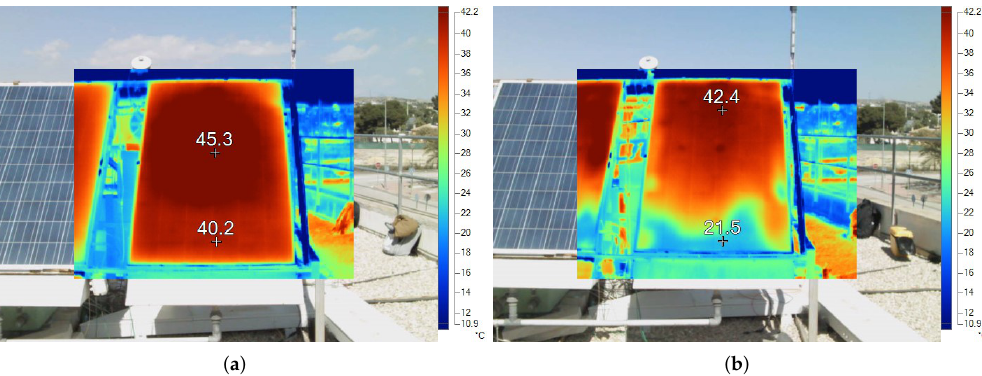
Figure 9. Thermographic evaluation of the module temperature distribution. ( a ) Evaporative chimney on and ( b ) evapora- tive chimney off.